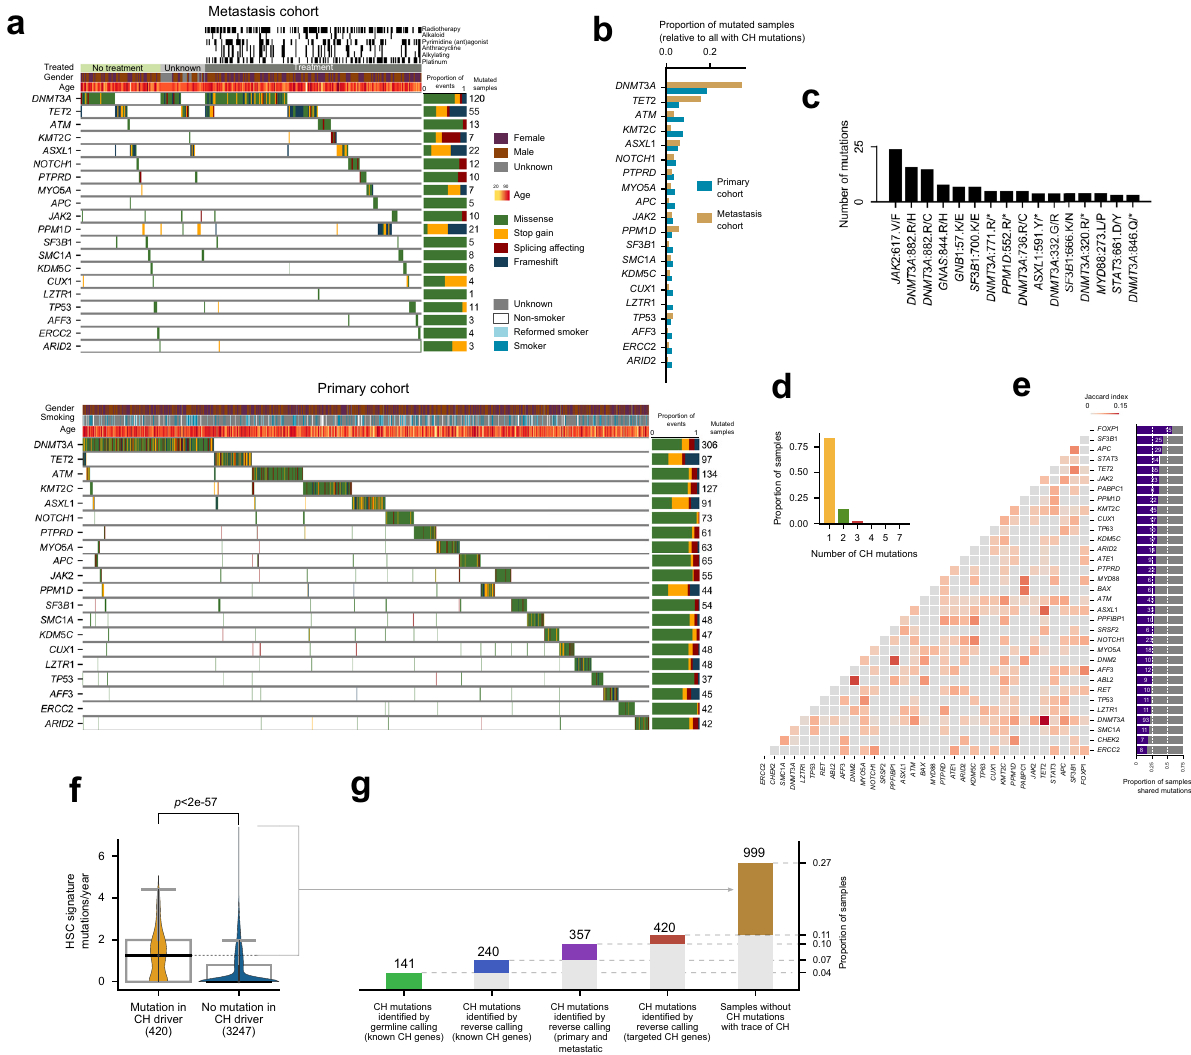
Fig. 4 Clonal hematopoiesis across 12,000 donors. a Blood somatic mutations in the 20 most recurrently mutated genes in the compendium across the metastasis (top) and primary (bottom) cohorts. b Frequency of mutation of CH drivers across the metastasis and primary cohorts. c The 16 most recurrently mutated hotspots in genes in the CH drivers compendium. d Number of donors in the two cohorts with mutations in genes in one or more CH drivers. e Frequency of co-occurring mutations in genes in the CH drivers compendium. Left, Jaccard ’ s index; right, frequency of gene pairs co-mutation. f Distribution of the rate of hematopoietic mosaic mutations per year (total number of HSC mutations divided by age) across (left) donors bearing a mutation in genes in the CH drivers compendium ( N = 420) and (right) donors with no detected mutations in any of these genes ( N = 3,247). The horizontal dashed line extends out of the median of the distribution of rate of mutation per year of age of the donors with mutations in at least one CH gene, representing the donors in the second group that are considered to be cases of clonal hematopoiesis (see next panel). In the boxplots, the box represents the second and third quartiles, separated by a line indicating the median; the whiskers represent the minimum and maximum of the distribution excluding outliers. The two distributions were compared using the two-tailed Wilcoxon-Mann-Whitney test. g Number of donors (above the bars) in the metastasis cohort with clonal hematopoiesis recognizable using different criteria (cumulative bars). First, donors with mutations (detected in the germline calling) in any of the 15 known CH genes; second, donors with variants in known CH genes identi fi ed in reverse calling; third, donors with mutations in CH genes discovered across the primary or metastasis cohorts; fourth, donors with mutations in CH genes discovered in the targeted cohort; fi fth, donors with no mutation in any gene within the compendium of CH drivers, but with more hematopoiesis mutations per year of age of the donor than the median rate of hematopoiesis mutations across donors in the four previous groups. Source data for panels a , b , c , d , e , f and g are provided as Source Data fi